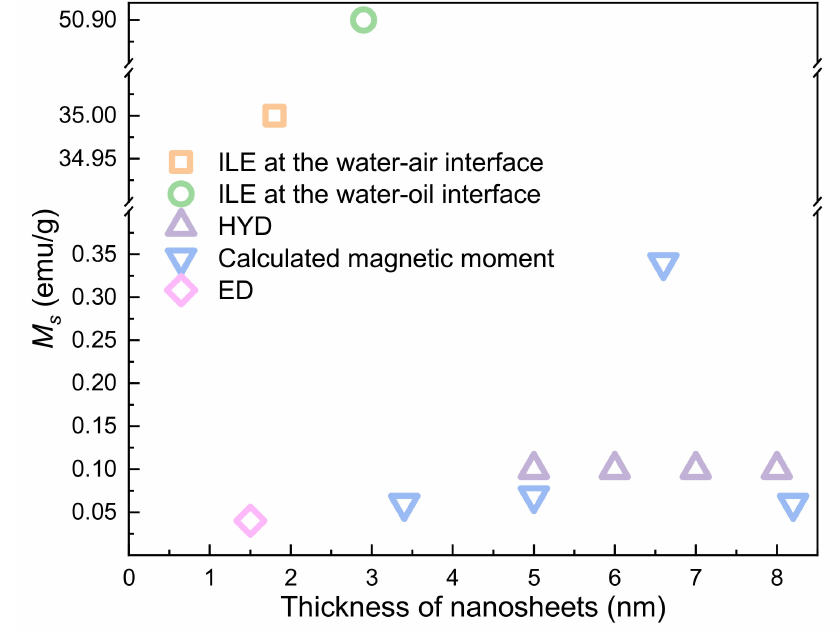
Figure 10. The thickness-dependent RTFM in ZnO